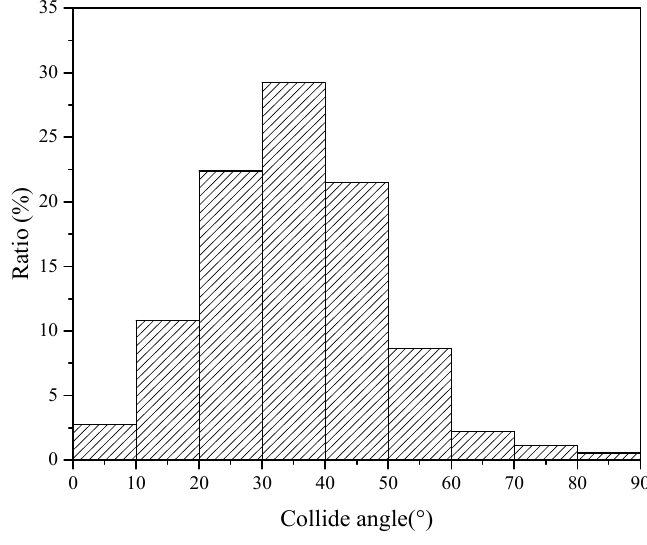
Figure 6. Ratio of particles in each collision angle.